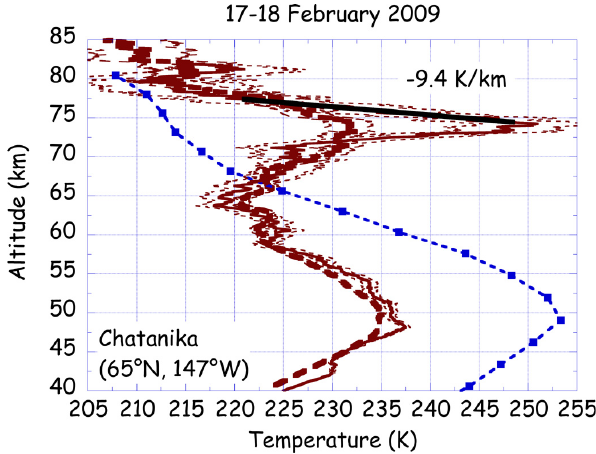
Fig. 1. Temperature profiles measured by Rayleigh lidar at Chatanika, Alaska on the night of 17–18 February 2009. The nightly average temperature measured over the interval 19:47– 07:12LST (04:47–16:12UT, thick dashed line) and the tempera- ture profile measured over the two hour interval 01:04–03:04LST (10:04–12:04UT, thin solid line) are plotted. The one-sigma tem- perature errors due to the statistical fluctuations in the lidar signal (dashed lines) and the SPARC February temperature profile (dashed line and solid squares) are also plotted. The linear fit to the topside of the mesospheric inversion layer is indicated.